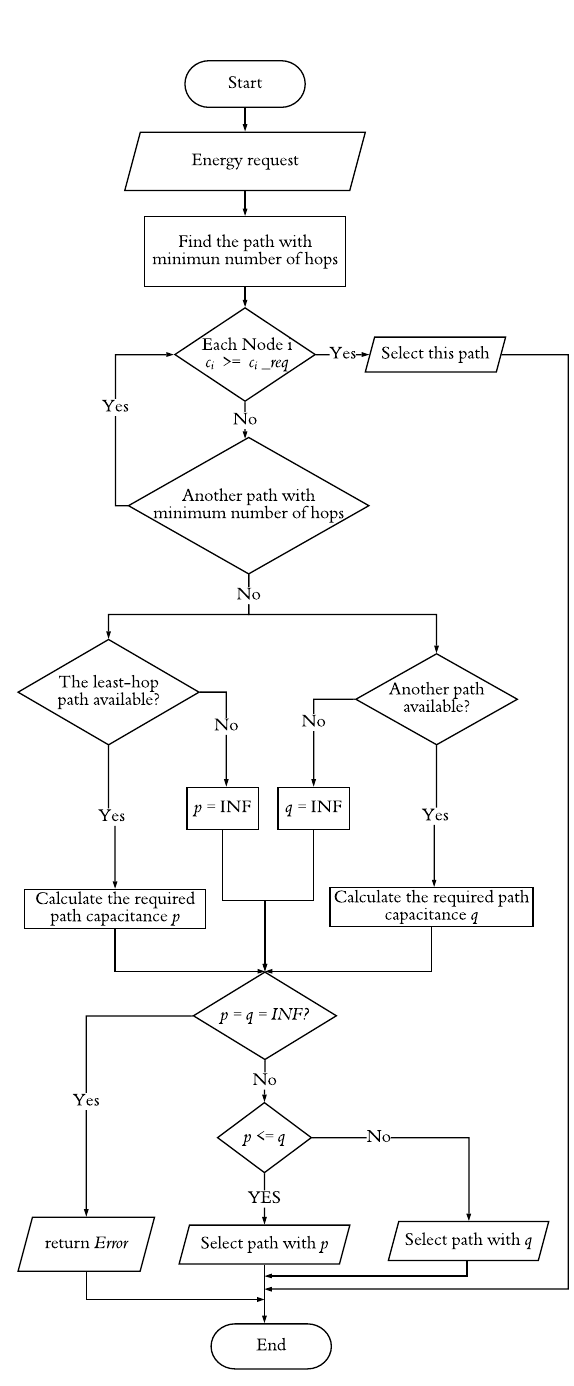
Figure 6. Flowchart of the proposed path selection